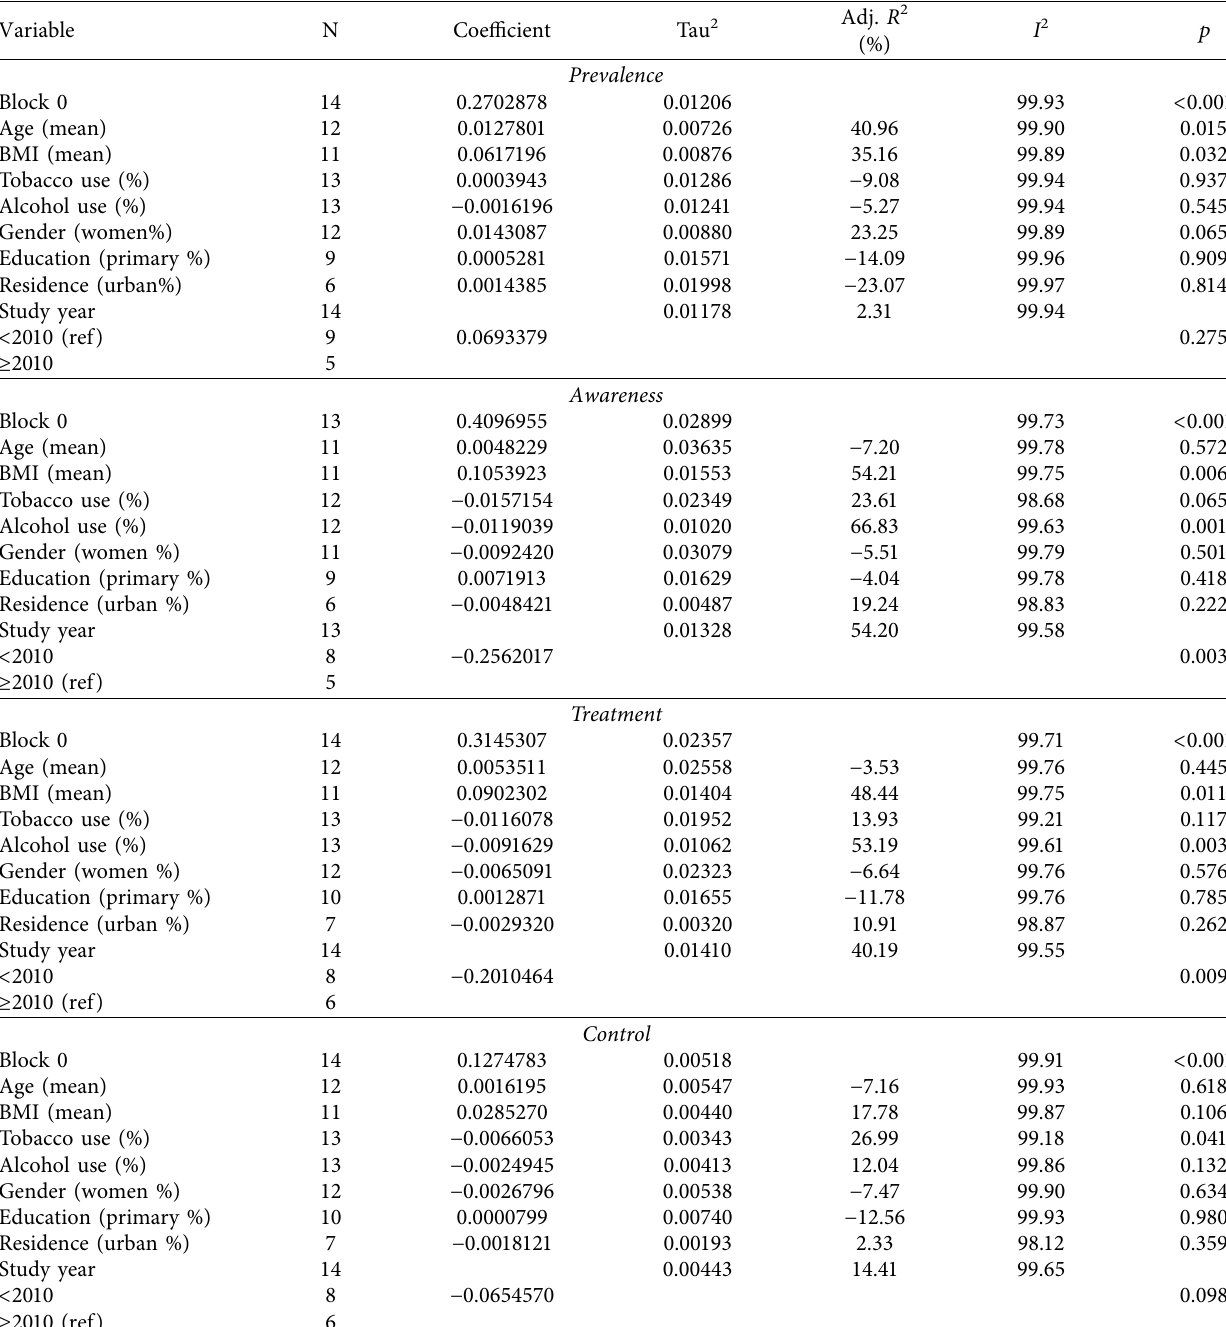
Table 2: Meta-regression analysis of the Han group to explore potential sources of heterogeneity, prevalence, awareness, treatment, and